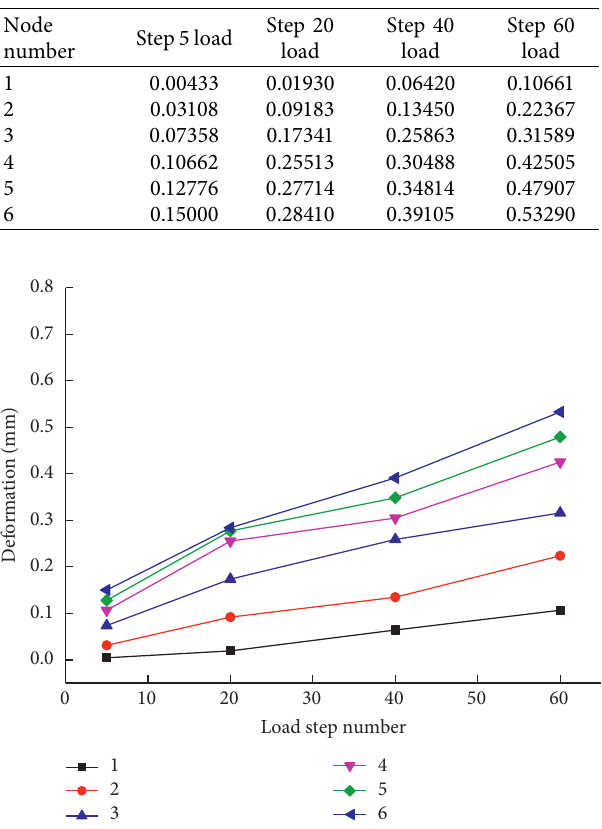
Table 4: Deformation values in the direction of Y -axis under different load substeps.